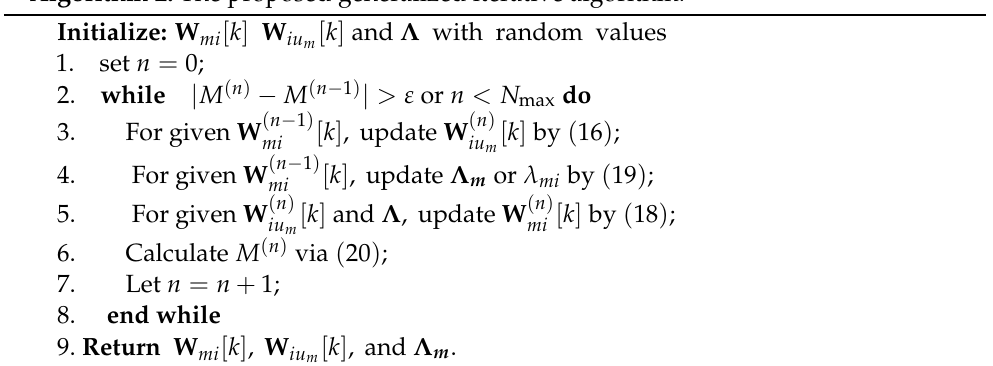
Algorithm 2: The proposed generalized iterative